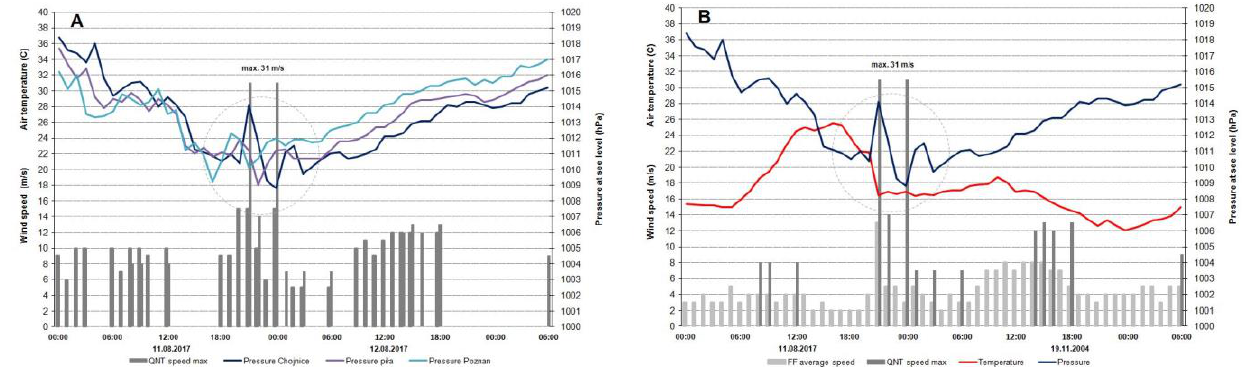
Fig. 4. Daily course of pressure and wind gusts at Poznań, Piła and Chojnice meteorological stations (A) and daily course of pressure, wind gusts and temperature only at Chojnice station (B). Source of data: